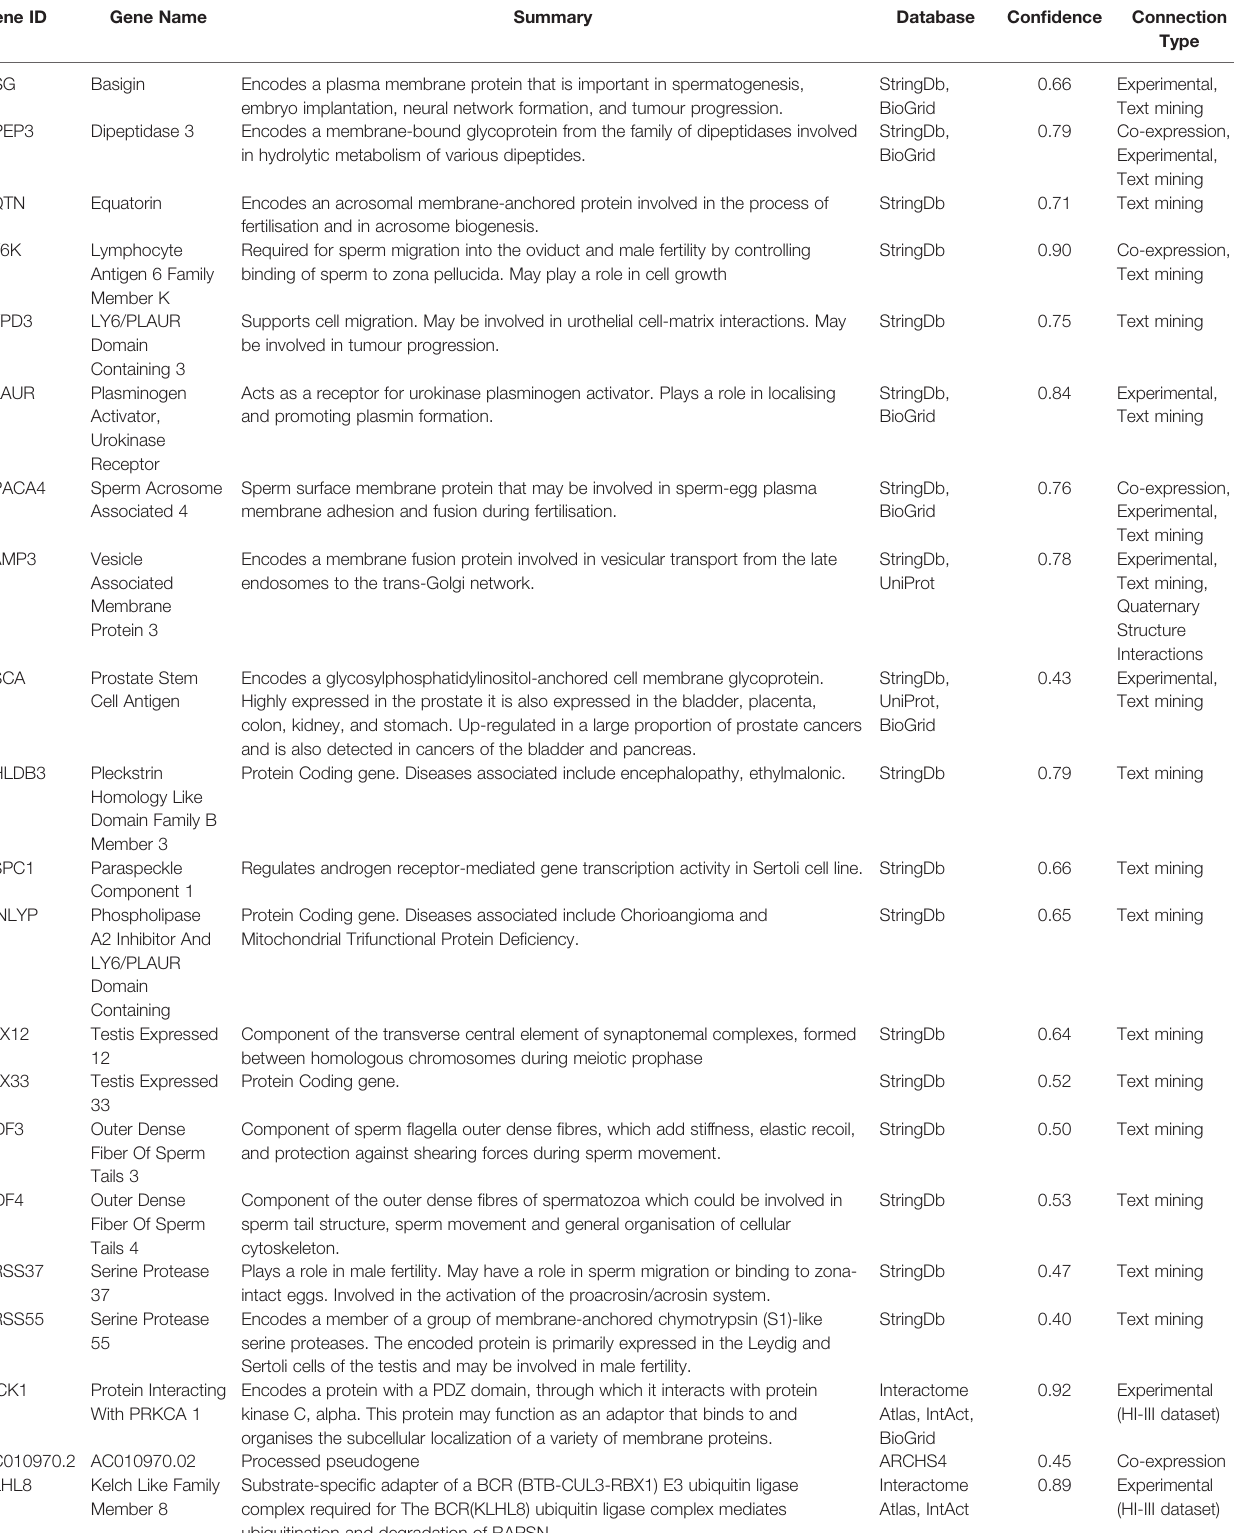
TABLE 1 | List of TEX101 interacting components, as well as the databases the genes or proteins were taken from. Summary of gene function was retrieved from